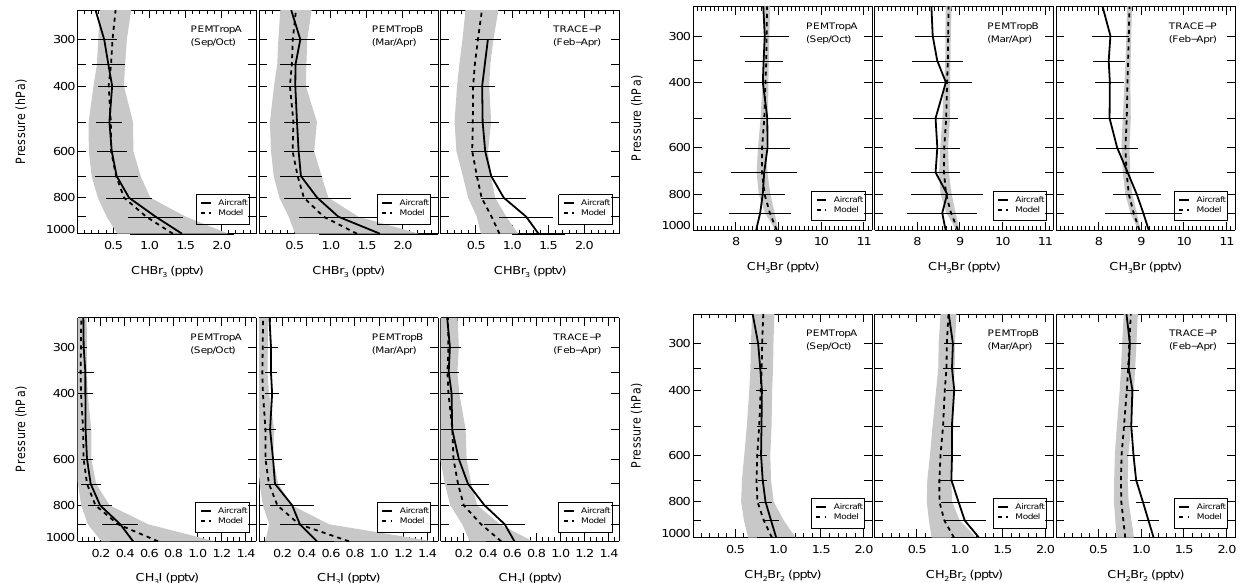
Fig. 1. Comparison of average vertical profiles of CHBr 3 , CH 3 I, CH 3 Br and CH 2 Br 2 as simulated by CAM-Chem (dashed lines) for the last of a 10-yr run with a composite of aircraft observations (solid lines) in the tropical regions from the missions PEM-Tropics A (1996), PEM-Tropics B (1999) and TRACE-P (2001). Model results are averaged within the geographical region of each campaign considering latitudes between 30 ◦ N and 30 ◦ S and matching seasons. Shaded areas and horizontal bars represent the standard deviation of modelled fields and observations,